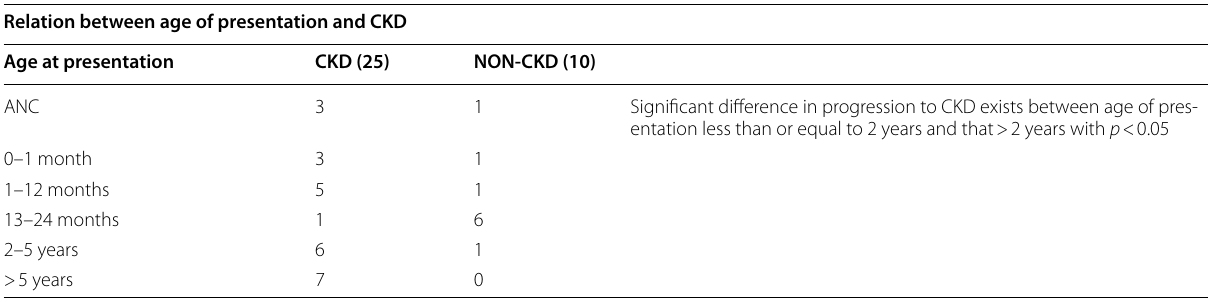
Relation between post-fulguration creatinine level trend and progression to CKD CKD Non-CKD Total number of patients Increasing